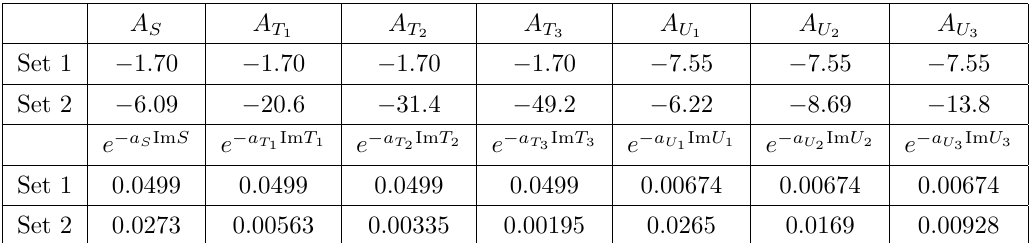
Table 6 . The values of A i and of e (cid:0) a i Im(cid:8) i for the two anti-de Sitter